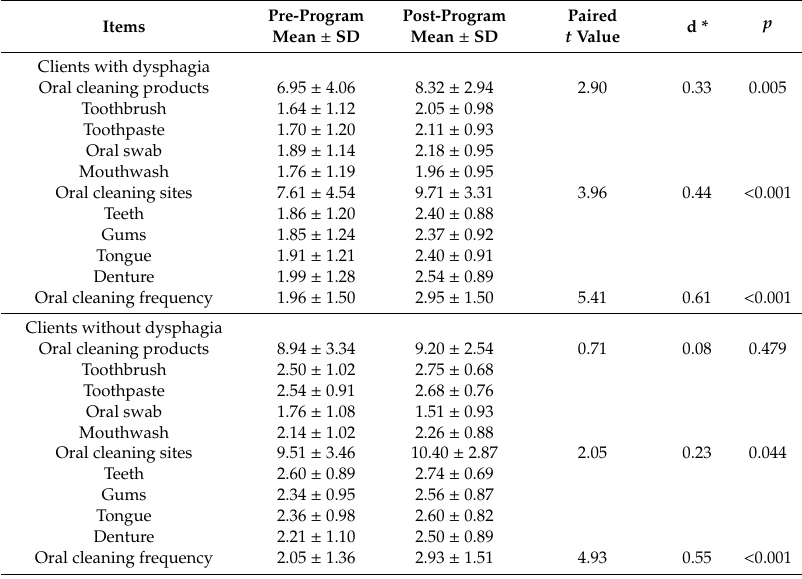
Table 4. Change in oral hygiene skills (N =